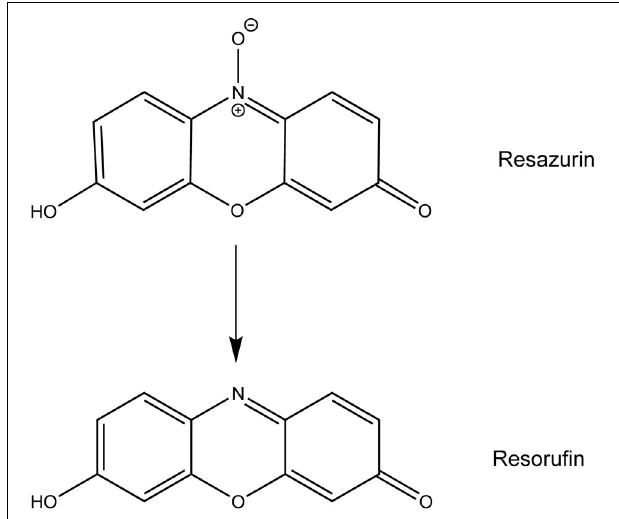
FIGURE 1 | The reduction of resazurin to resorufin.